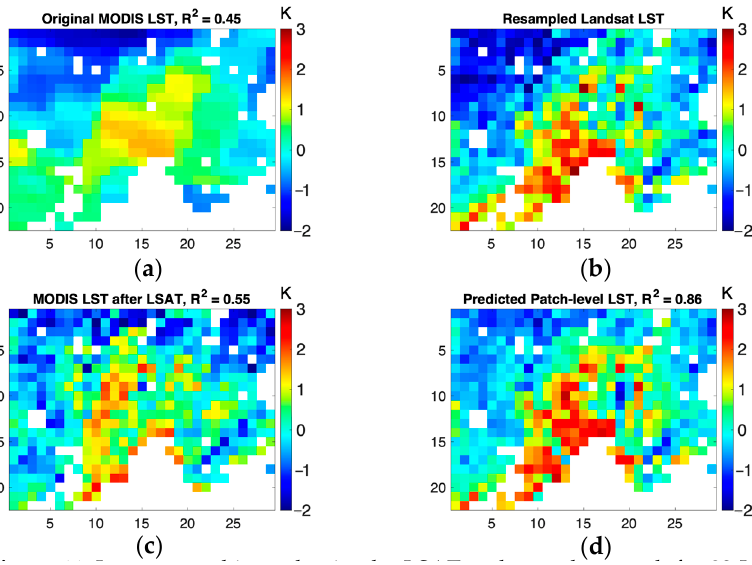
Figure 11. Inter-sensor bias reduction by LSAT and neural network for 23 January 2015. ( a ) is the original MODIS LST, ( b ) is the resampled Landsat LST on the same date, ( c ) is the MODIS LST adjusted by LSAT, and ( d ) is the LST predicted by the neural network. All the LST images are free of scene-scale mean, showing intra-scene variations only. The spatial 𝑅 (cid:2870) of ( b ) with ( a , c , d ) is marked.